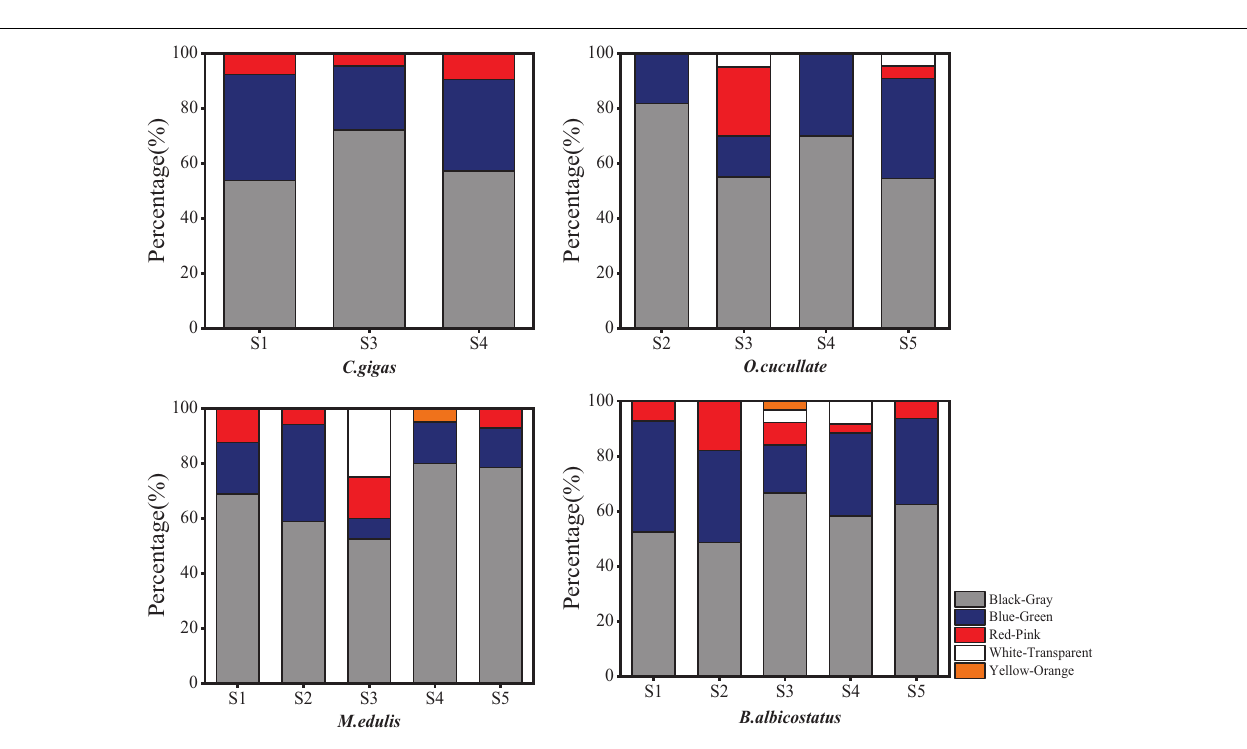
Frontiers in Marine Science |